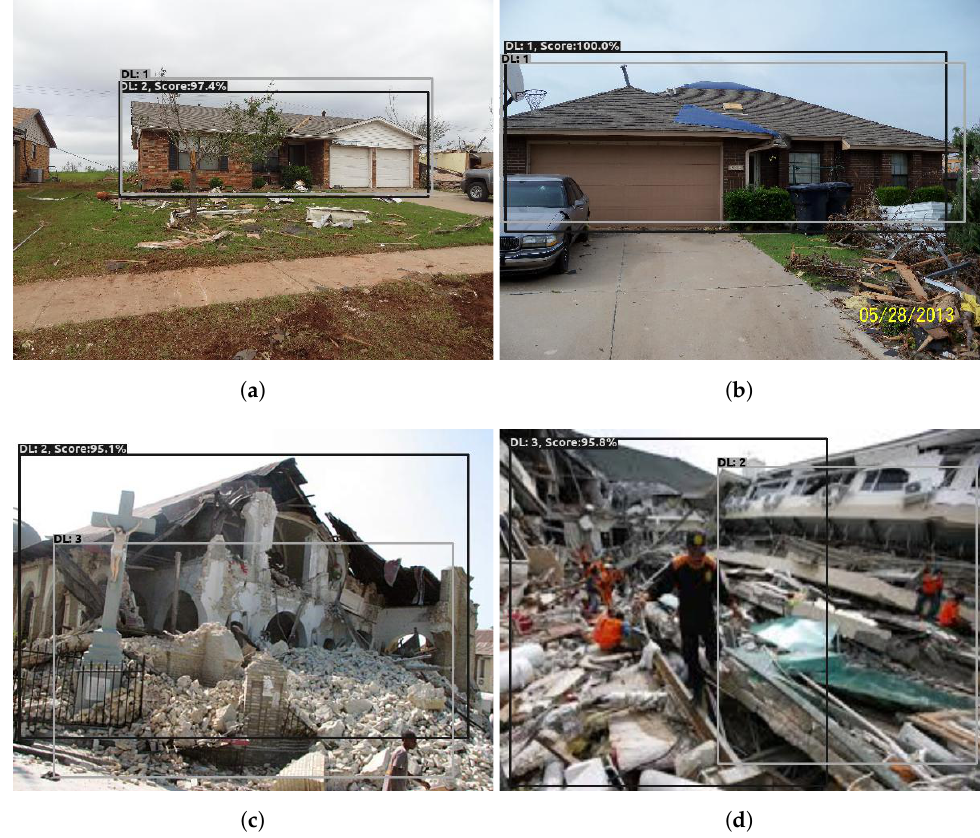
Figure 9. Damage-level prediction using M DL ( FRC , RN ) : ( a ) minor-damage scene (predicted as moderate damage with a score of 97.4%); ( b ) minor-damage scene (correct prediction with a score of 100.0%); ( c ) major-damage scene (predicted as moderate damage with a score of 95.1%); ( d ) mislabeled moderate-damage scene (predicted as major damage with a score of 95.8%). Table 4. Confusion Matrix of damage-level Models.